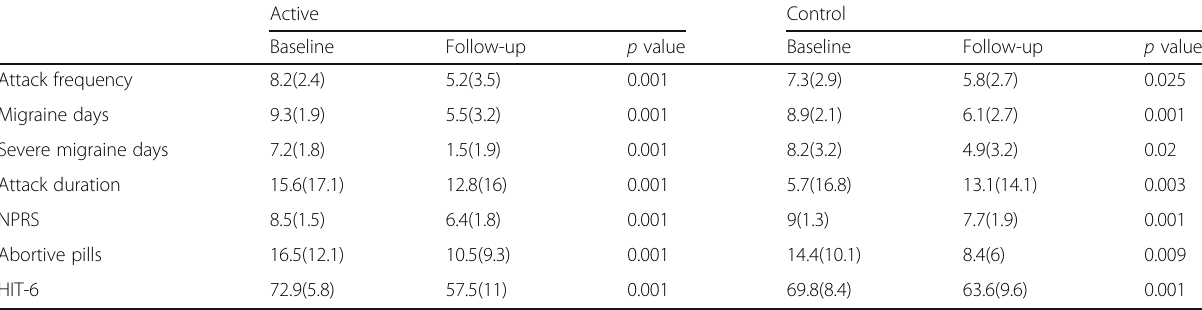
Table 2 Follow up of the two treatment